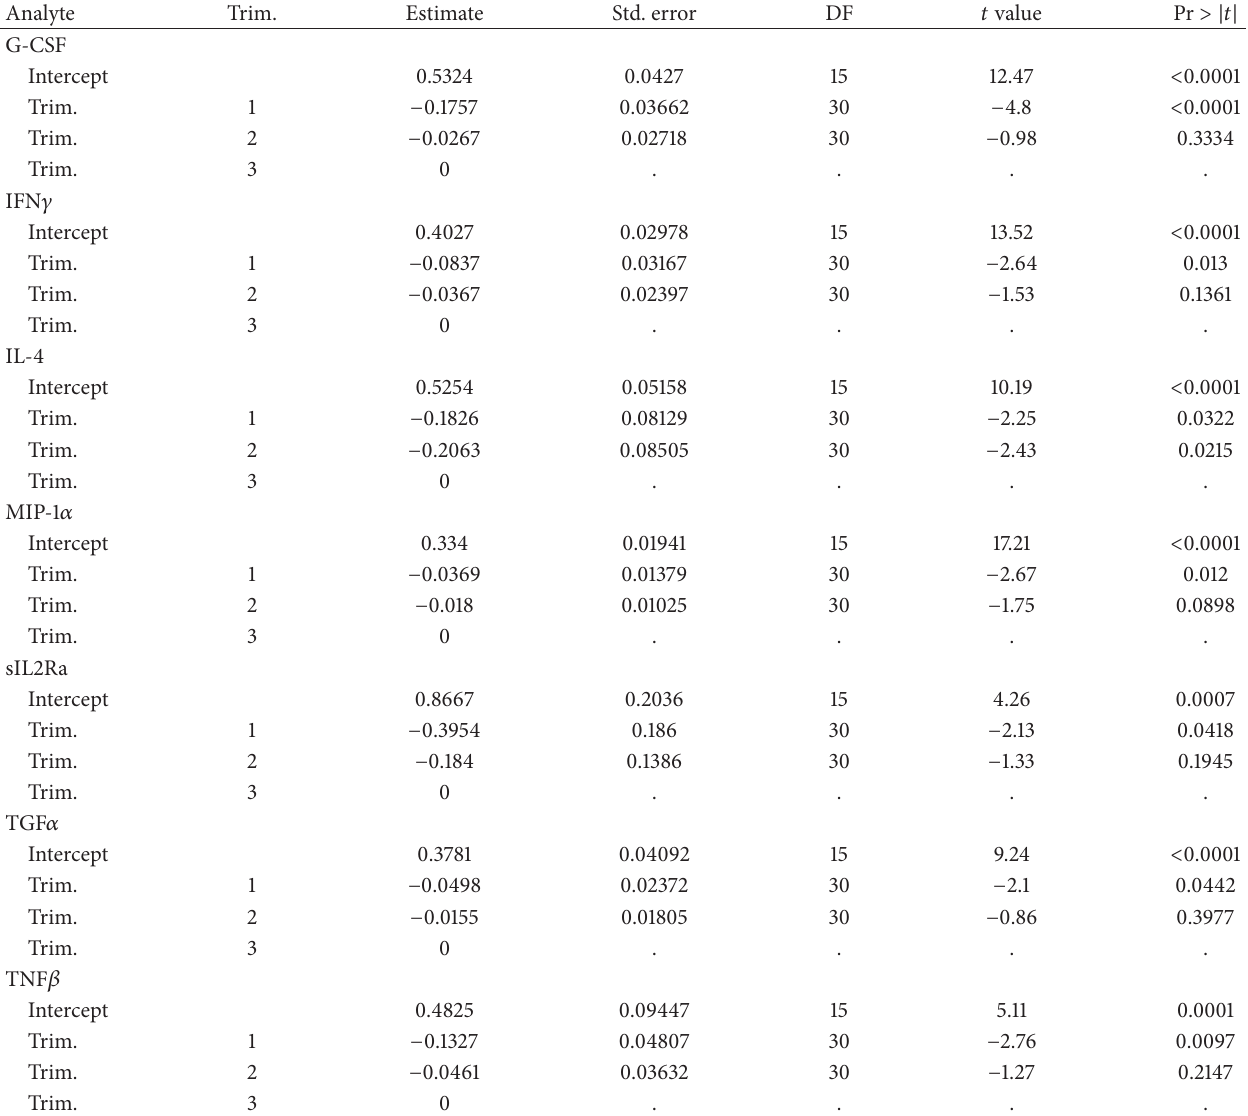
Table 4: Cytokines with categorical trimester as the time